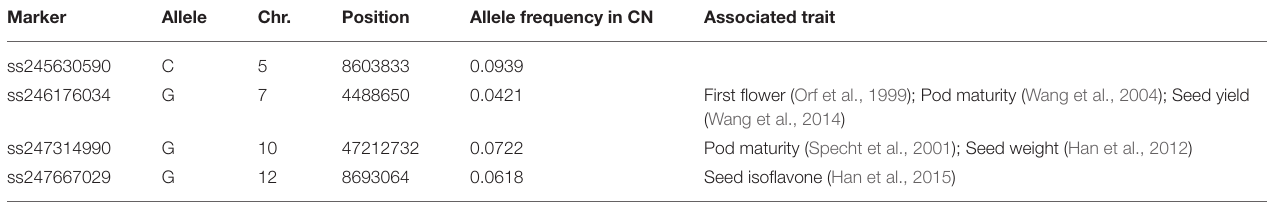
TABLE 3 | Population-specific alleles for Chinese soybean genotypes. Marker Allele Chr. Position Allele frequency in CN Associated